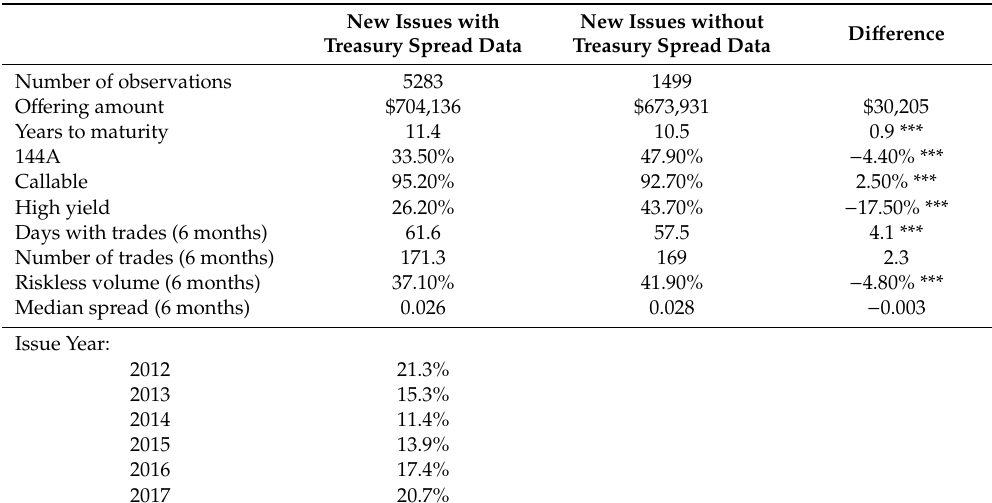
Table 2. New Issues Sample